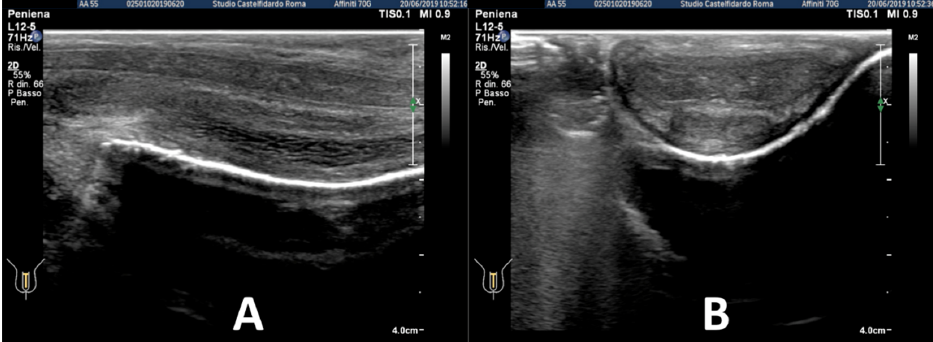
Figure 10. Ultrasonography of the penis after the fourth treatment cycle. ( A ) longitudinal view, ( B ) transverse view.